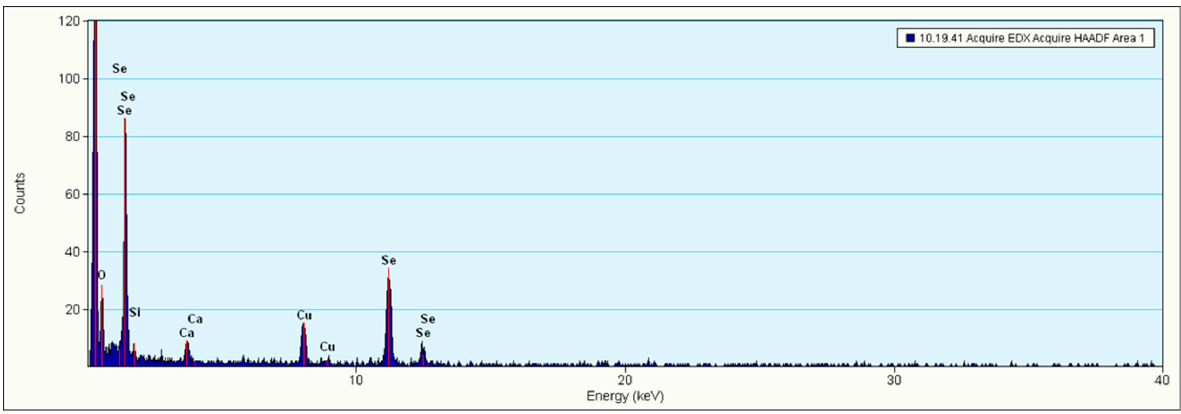
Figure 5. EDX spectrum of the PSNC14